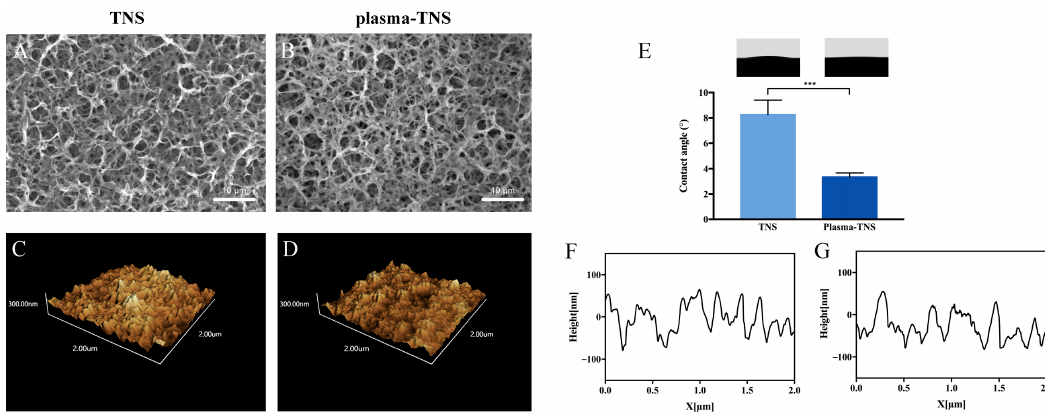
Figure 1. Scanning electron micrographs of ( A ) Titanate layer with nanonetwork structures (TNS) and ( B ) plasma-TNS; Scanning probe micrographs and a typical surface profile of ( C , F ) TNS and ( D , G ) plasma-TNS. ( E ) The measurement of the contact angle on the surface of TNS and plasma-TNS. Data shown are the means ± SD ( n = 3). *** p < 0.001. Table 1. Roughness values of the TNS and plasma-TNS. Data shown are the means ± SD ( n = 3). Group